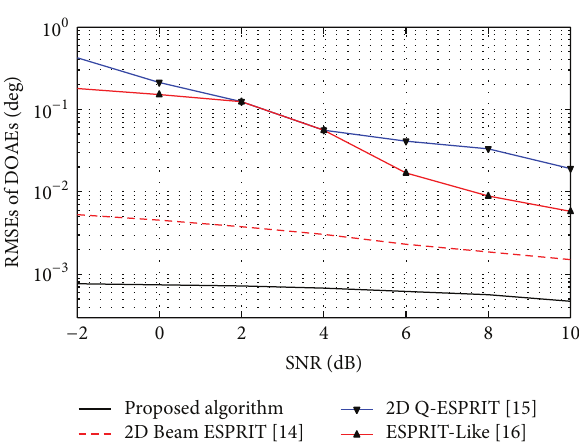
Figure 8: RMSEs versus SNR for T-ESPRIT with the Doppler effect embedding compared with different ESPRIT methods.